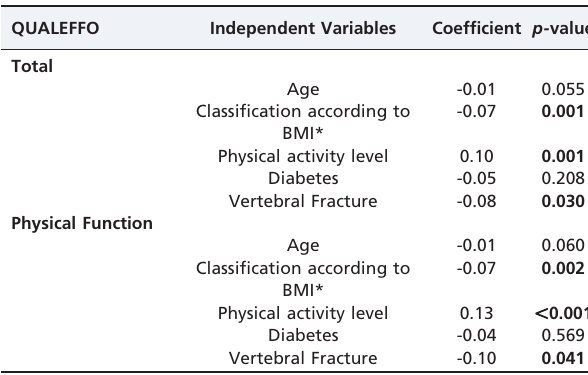
Table 4 - Generalized linear